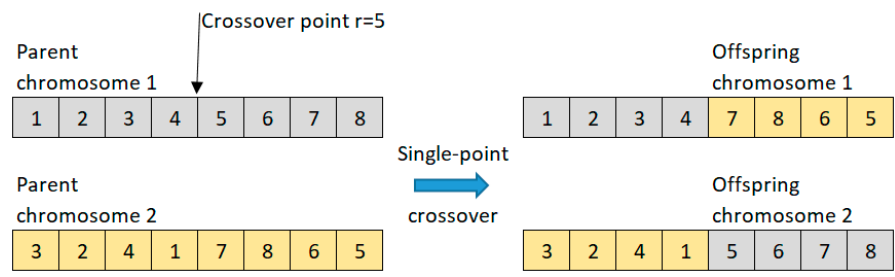
Figure 3. Single-point crossover for a pair of chromosomes of length l = 8. Mutation operation corresponding to a spurious gene change after crossover, as illustrated in Figure 4.